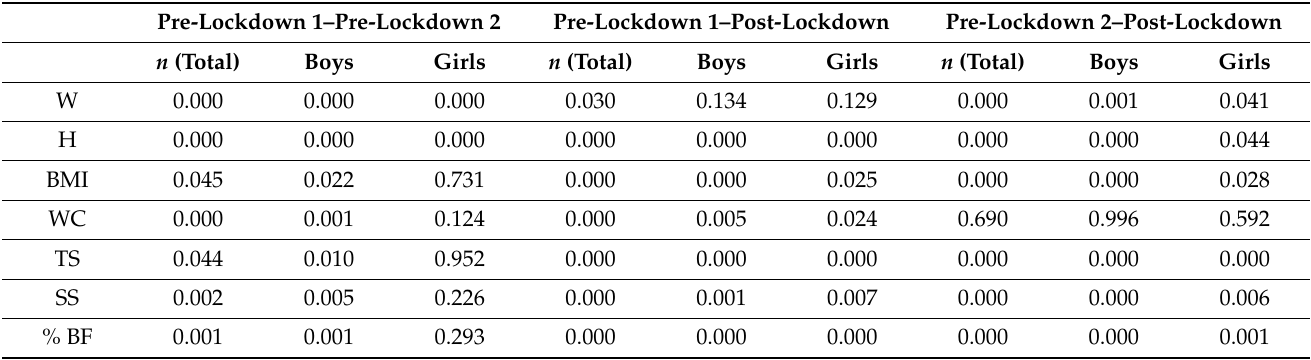
Table 1. Significance results for anthropometric variables as a function of data collection and gender. Pre-Lockdown 1–Pre-Lockdown